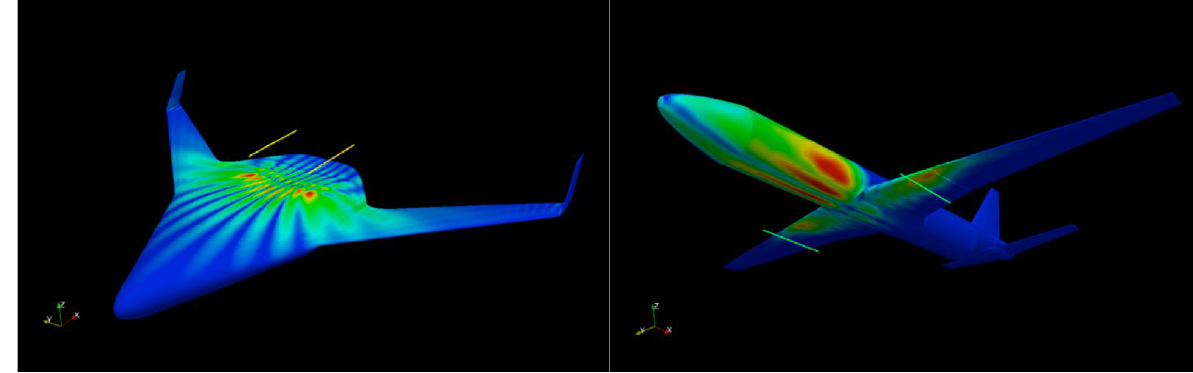
Figure 12: Total SPL distribution induced, at 200 Hz, by the fan on the surface of the BWB and a classic configuration of the same class.